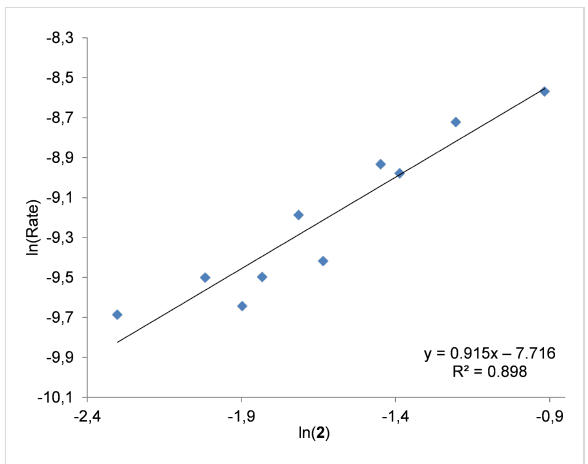
Figure 9: Double logarithmic plot to determine the order with respect to the bifunctional Zn complex 2 in the presence of NBu 4 I. Conditions: 1,2-epoxyhexane (10 mmol) as substrate, 40 °C, 1 MPa of CO 2 , 2 h; [2] = 0.1–0.4 mol %, [NBu 4 I] = 0.6 mol %